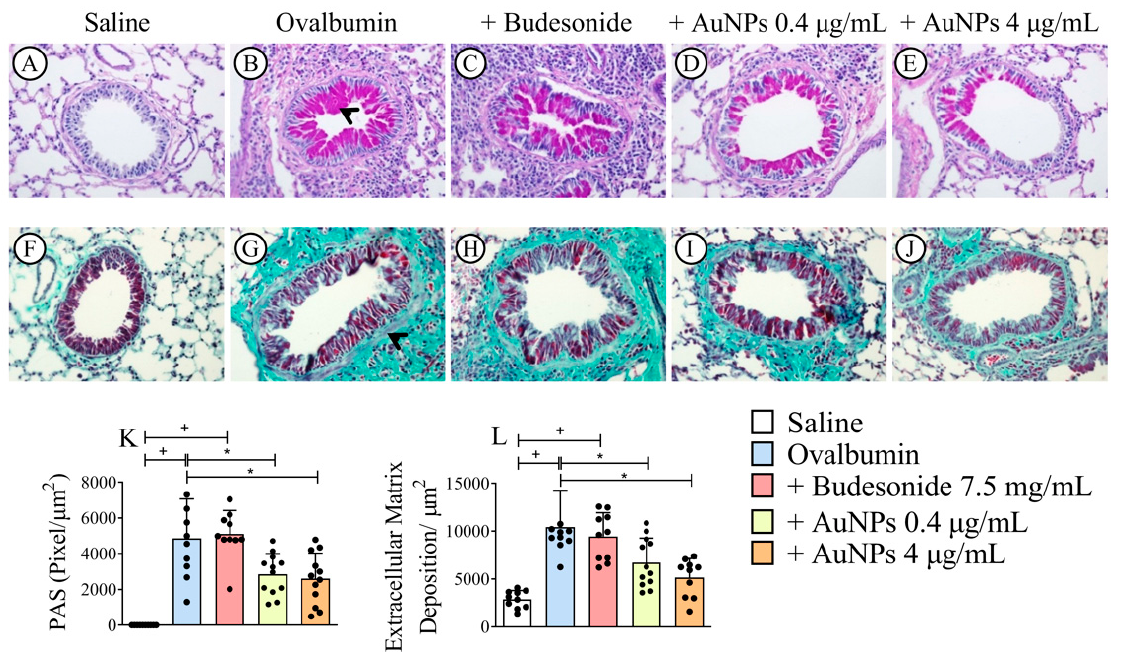
Figure 3. The effect of nebulized Budesonide or gold nanoparticles (AuNPs) on mucus production and airway remodeling following ovalbumin intranasal instillation given once a week for 9 weeks. Photomicrographs were taken of representative airways stained by periodic acid-Schiff ( A – E ) or Gömöri trichrome ( F – J ) from ovalbumin-sensitized mice challenged with saline ( A , F ), challenged with ovalbumin ( B , G ), challenged with ovalbumin and treated with Budesonide ( C , H ), challenged with ovalbumin and treated with AuNPs (0.4 µ g/mL) ( D , I ) and challenged with ovalbumin and treated with AuNPs (4 µ g/mL) ( E , J ), respectively. Quantitative assessments of mucus production ( K ) and fibrotic changes ( L ) were carried out in lung sections by morphometric analyses. Data are expressed as mean ± SD (Each dot represents an individual mouse; n = 10 for all groups). + p < 0.05 as compared with the saline group, * p < 0.05 as compared with the ovalbumin-challenged group.